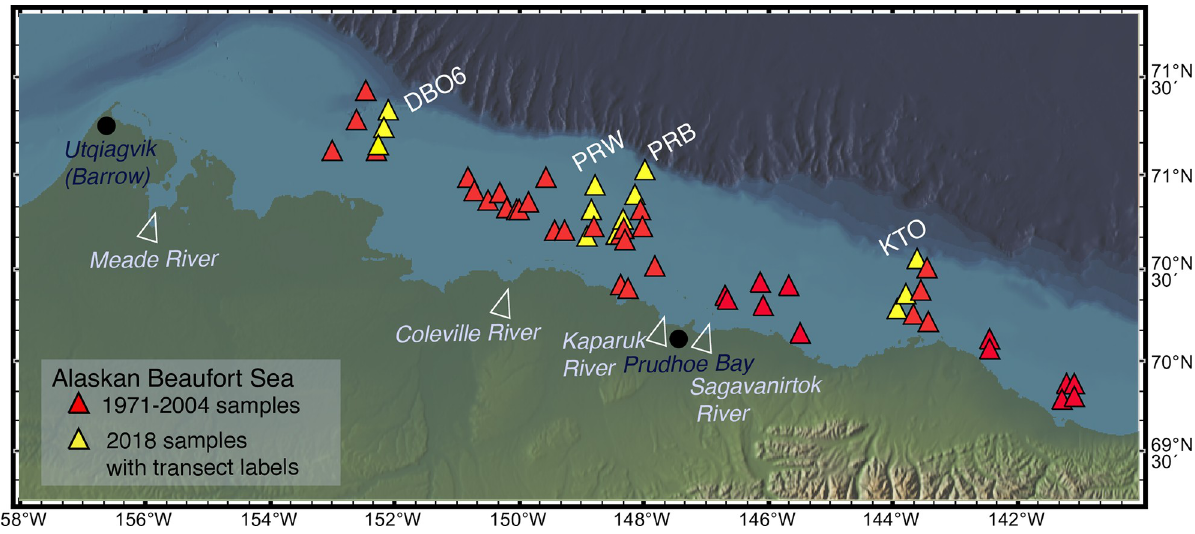
Fig 3. Location of samples used in Beaufort Sea ecological transect study from years 1971–2018 (n = 55 surface sediment aliquots with � 30 specimens per sediment sample, 20-100mwd, 6,617 total specimens). Figure made with GeoMapApp [29] (www.geomapapp.org) / CC BY / CC BY